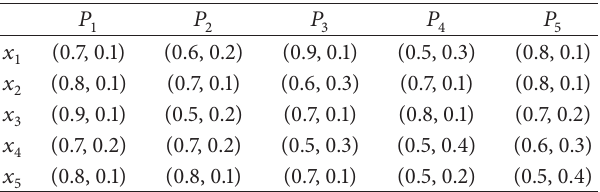
Table 2: Intuitionistic fuzzy decision matrix 𝑅 (1) .